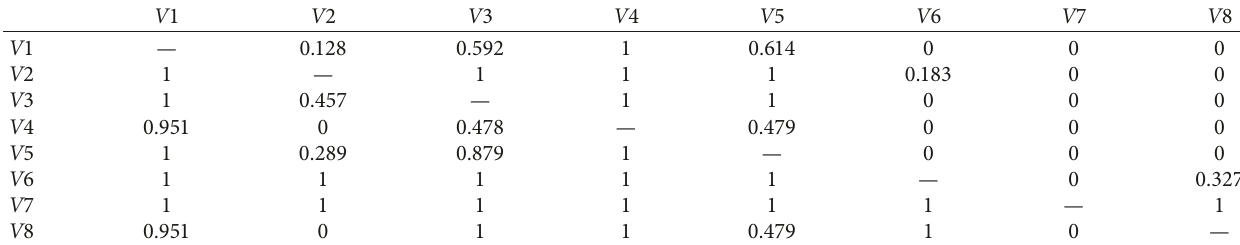
Table 8: The degree of magnitude of the indicators in relation to the main goal.